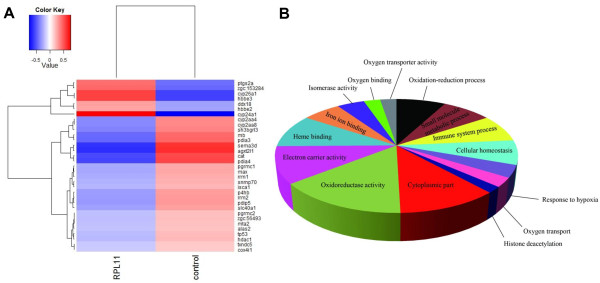
Analysis of affected hematological genes in Rpl11-deficient zebrafish embryos at 48 hpf. A, Cluster analysis of affected hematological genes. A total of 33 hematological genes exhibited changed expression in Rpl11-deficient zebrafish embryos at 48 hpf (FC >1.5, p-value <0.05). Hematological genes were clustered in upregulated and downregulated groups, and most affected hematopoietic genes were downregulated in Rpl11-deficient zebrafish embryos at 48 hpf; B, Gene ontology (GO) enrichment of affected hematological genes in Rpl11-deficient zebrafish embryos at 48 hpf. Among hematological genes, the largest three fractions represented oxidoreductase activity, cytoplasmic component, and electron carrier activity. Hematological genes with iron metabolism-associated functions such as heme and iron binding were also enriched.